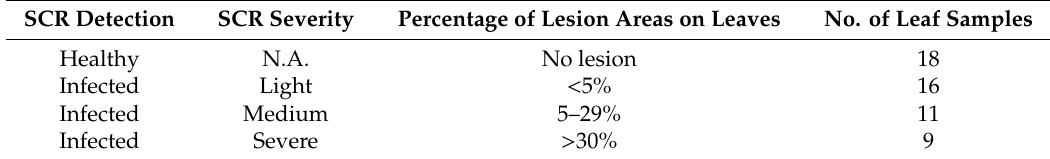
Table 1. SCR detection and severity classification scheme used in this